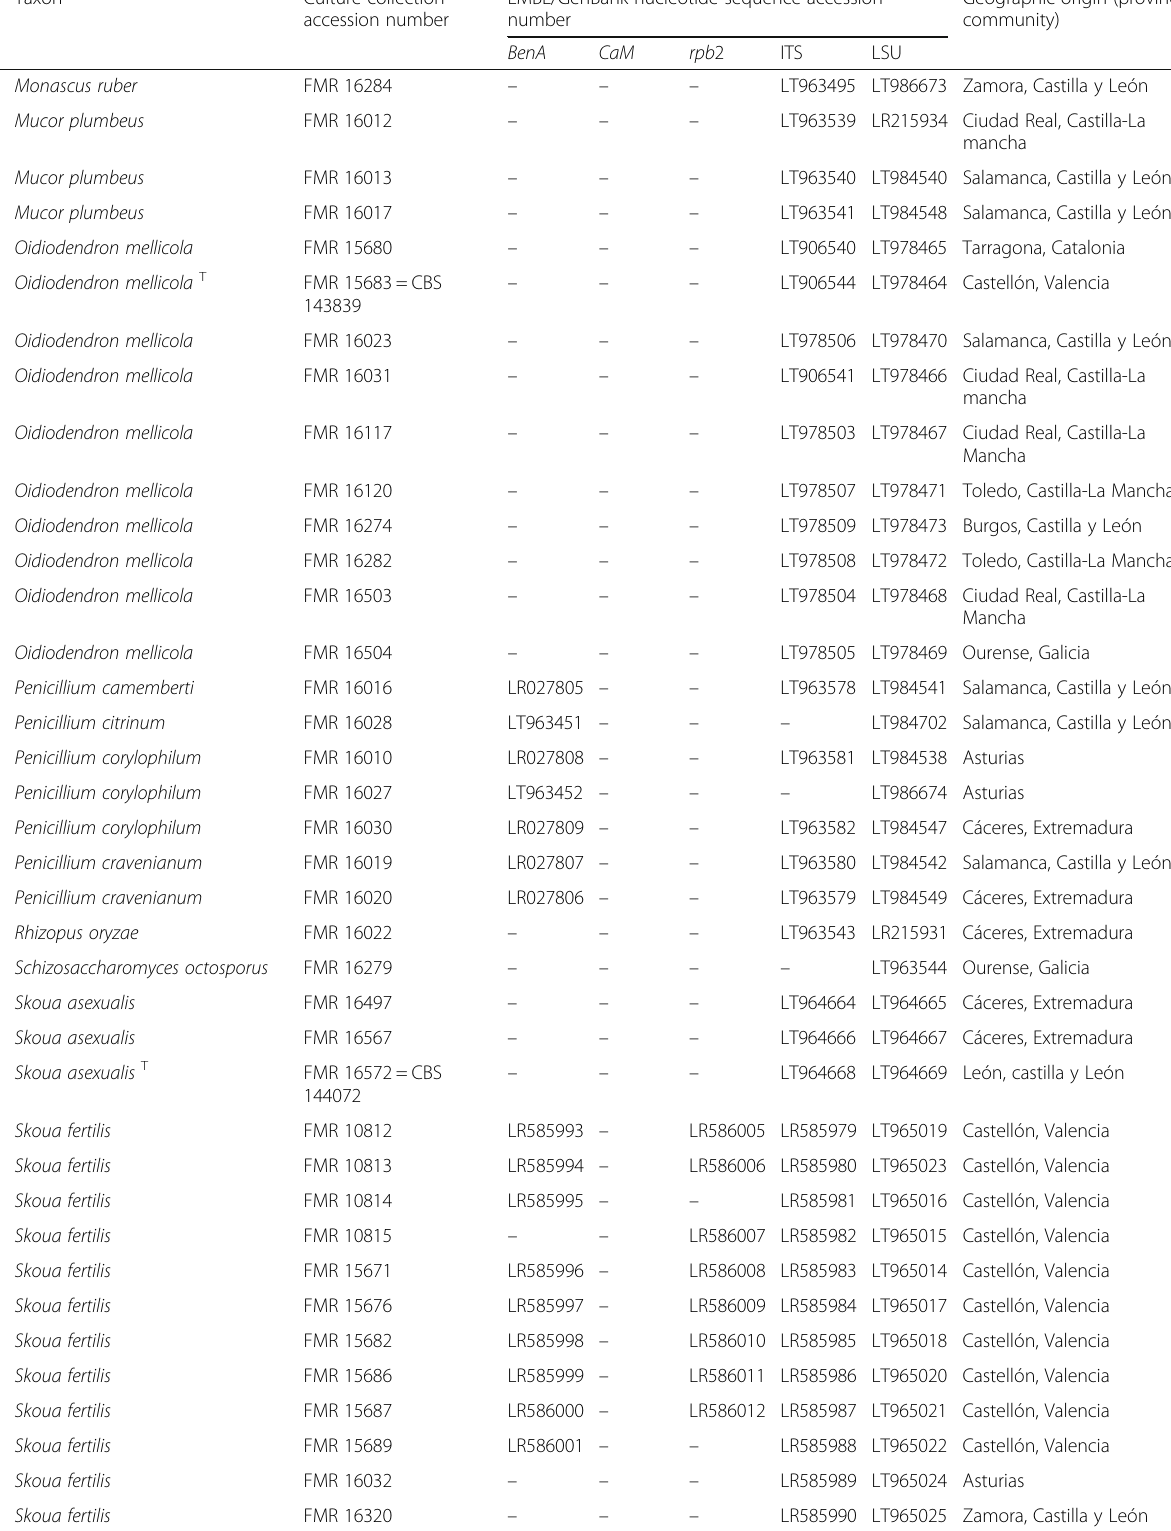
Table 1 Fungal taxa recovered with their nucleotide sequence accession number, and the geographic origin of the honey samples processed